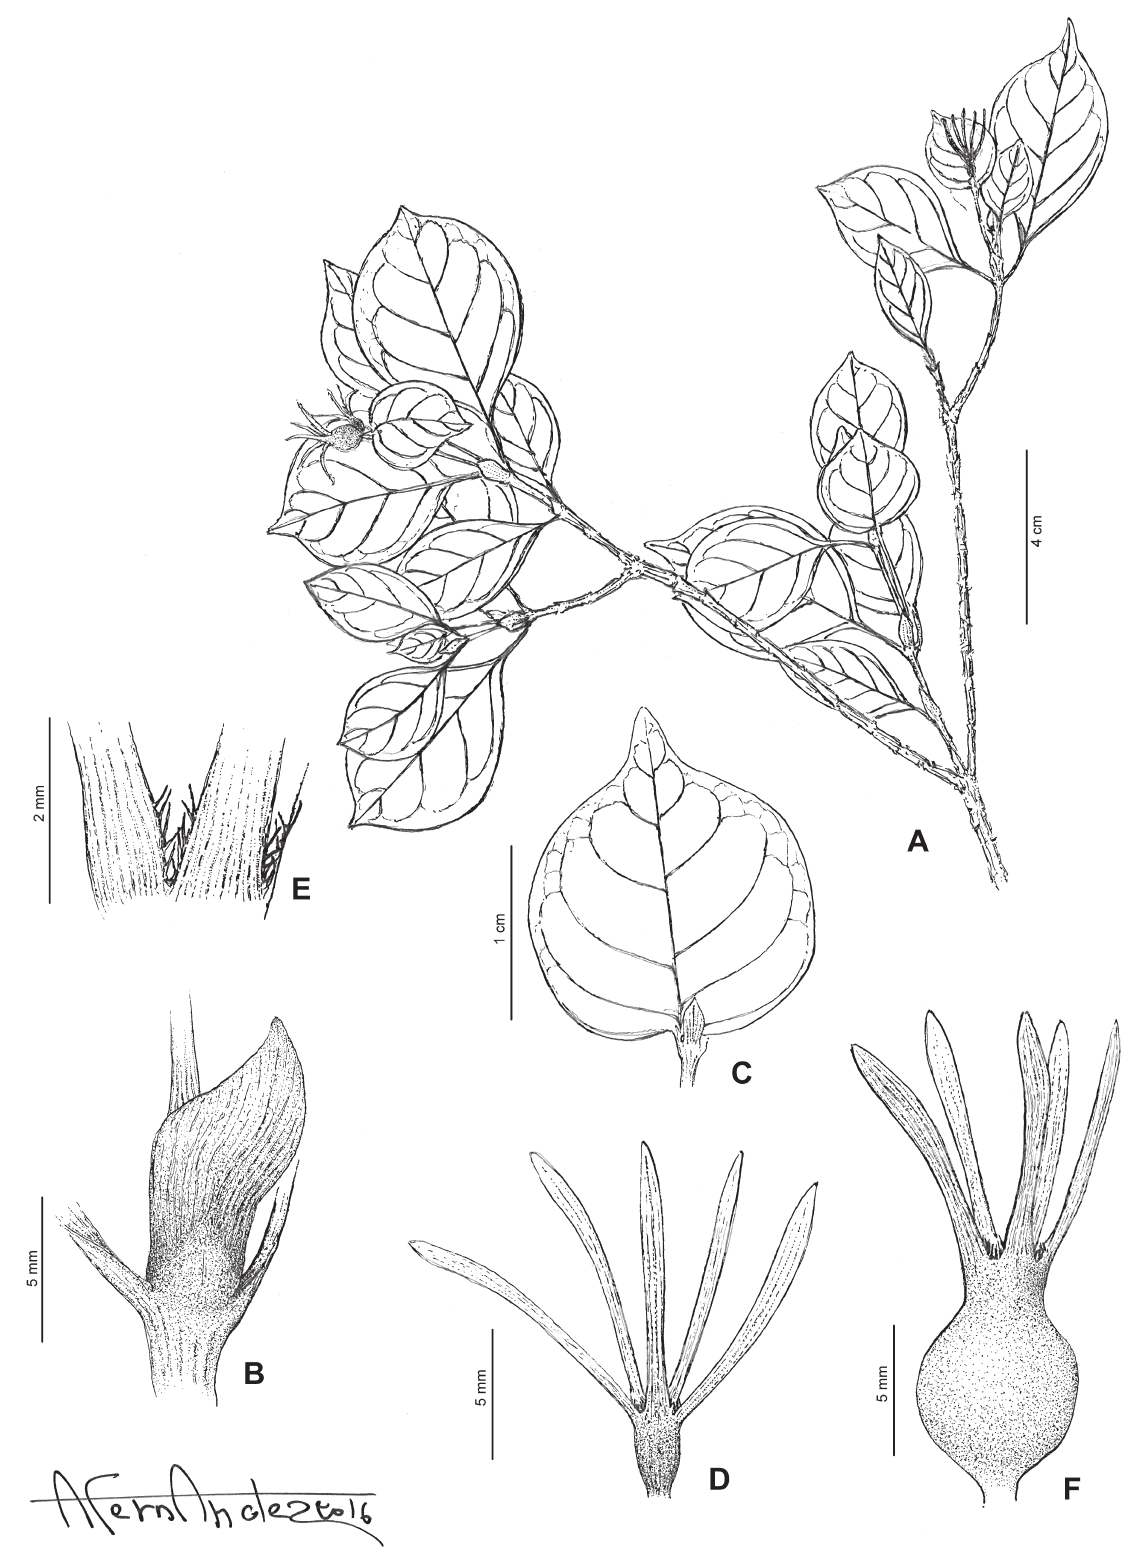
Fig. 1. Homollea furtiva De Block sp. nov. A . Fruiting branch. B . Stipule. C . First order bract. D . Ovary and calyx. E . Detail of D showing the sparsely ciliate base of the calyx lobes. F . fruit. Drawn by Mr. A. Fernandez. From Razafitsalama et al. 583